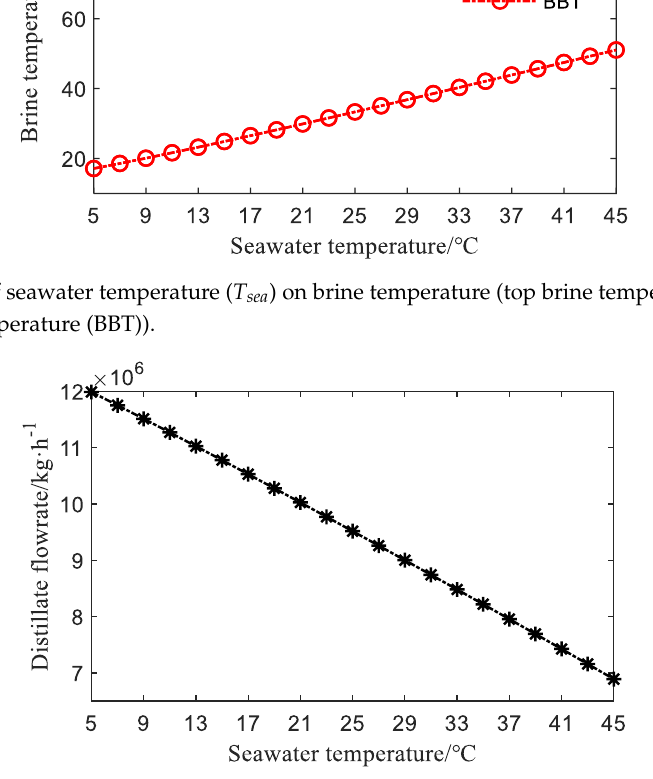
Figure 4. E ff ect of seawater temperature ( T sea ) on distillate flowrate ( W DN ).